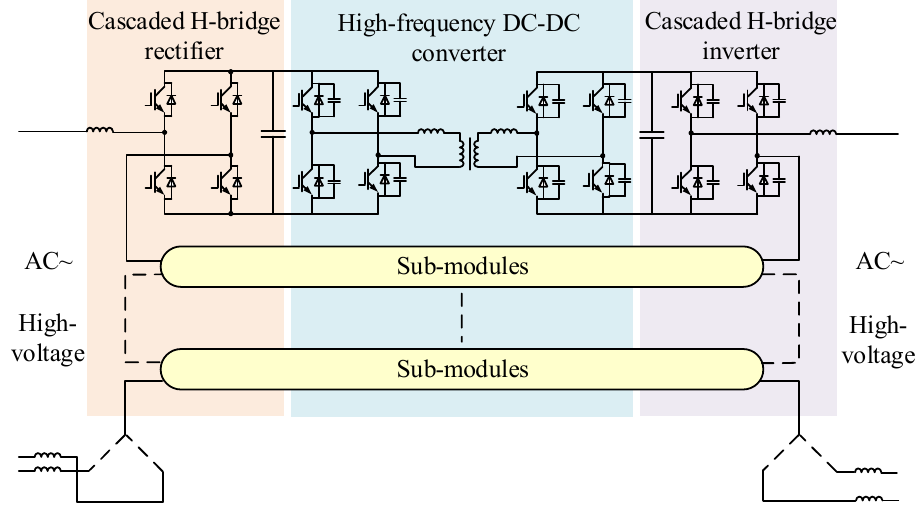
Figure 1. The main topology of the transformer-less cascaded H-bridge multilevel converter.